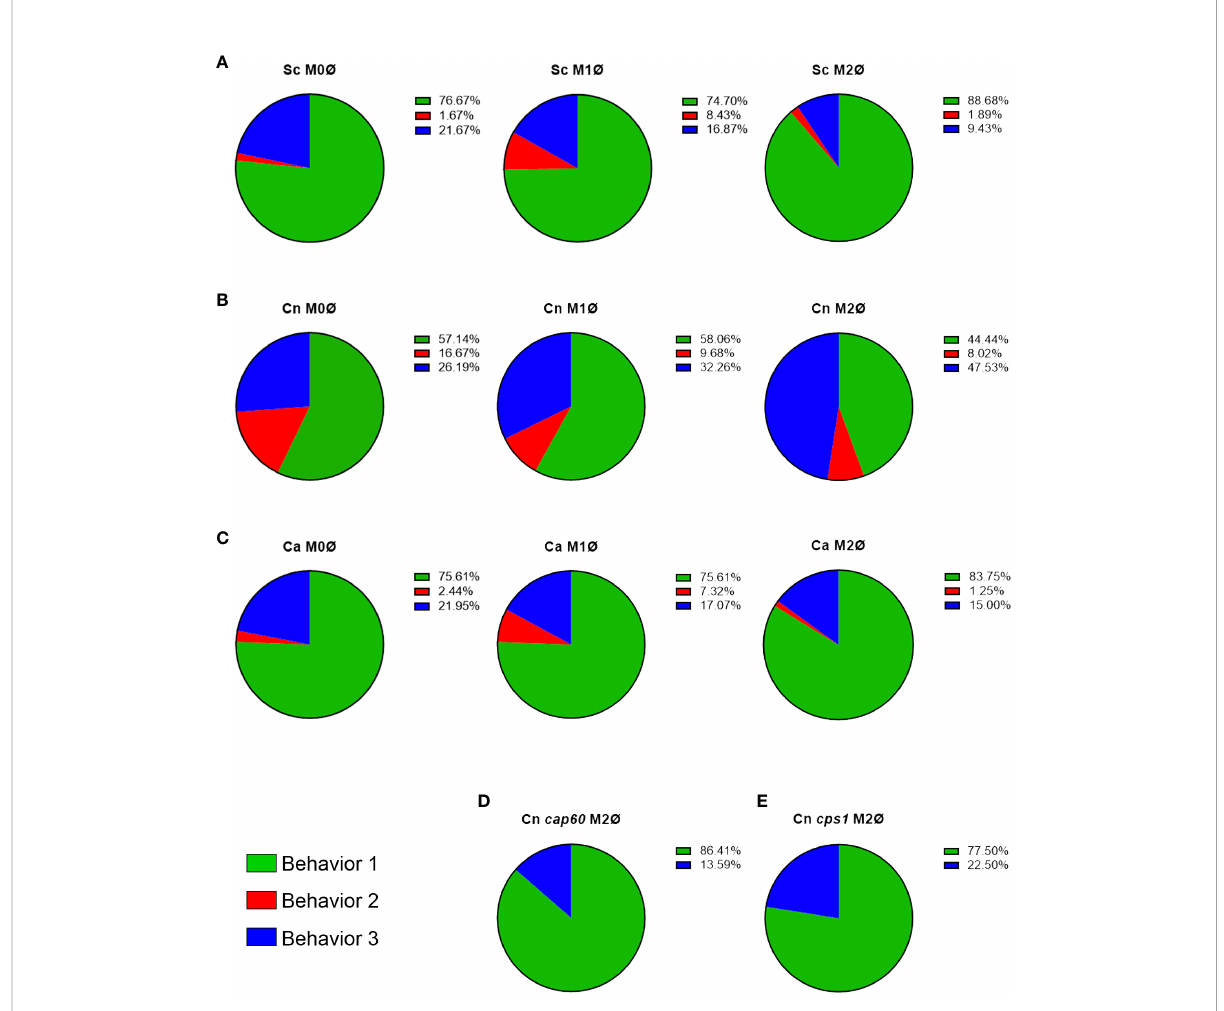
FIGURE 2 C . neoformans actively manipulates phagosomal pH in an immune-dependent way. (A – C) Quanti fi cation of all behaviors under all immune conditions of THP-1 cells infected with (A) S. cerevisiae (Sc), (B) C. neoformans (Cn), and (C) C. albicans (Ca). (D, E) Quanti fi cation of the behaviors exhibited by Cn mutants (D) cap60 D and (E) cps1 D in M2